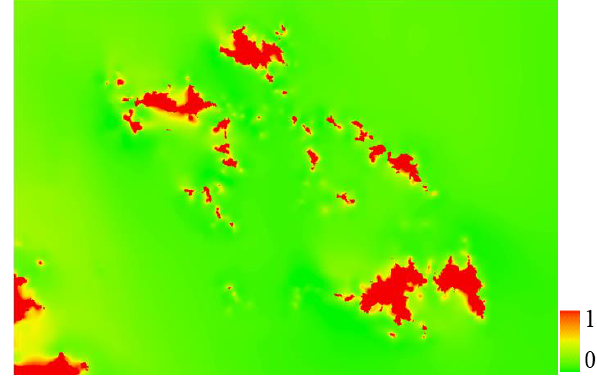
Figure 9. The depth hazard distribution map.